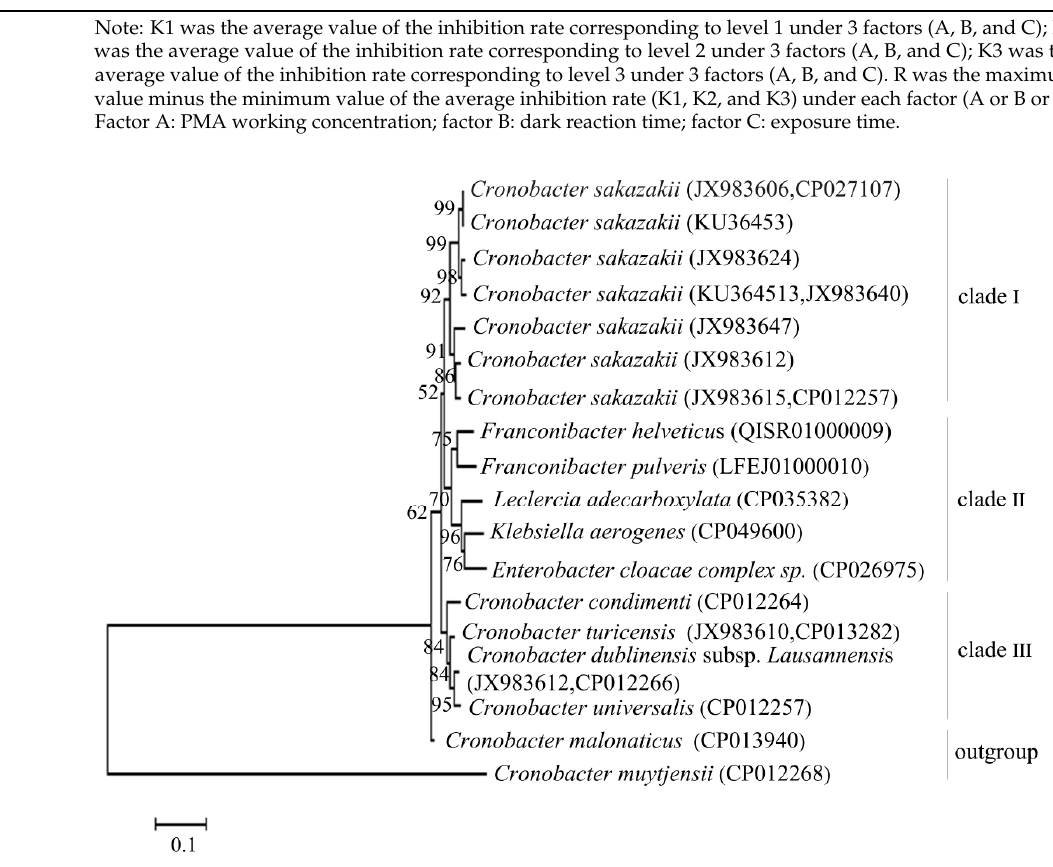
Figure 1. Phylogenetic tree was constructed by the gyr B gene of C. sakazakii and its related